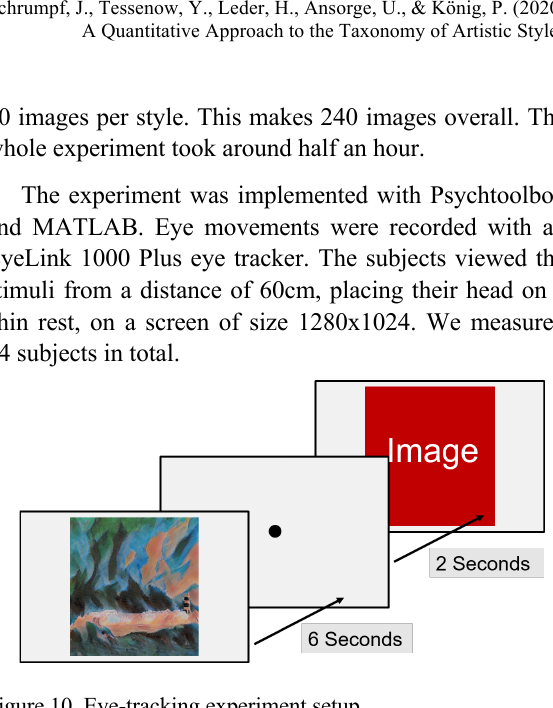
Figure 10. Eye-tracking experiment setup.